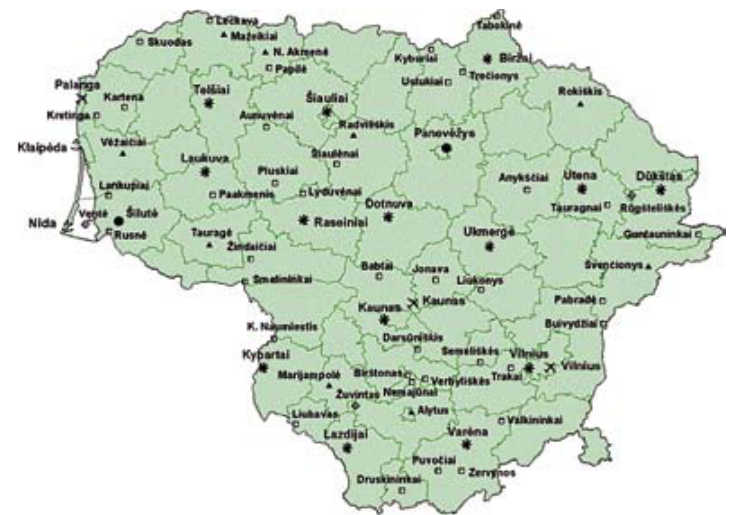
fig. 1. The network of observation stations of the Hydrometeorological Service (Juknevičiūtė, Laurinavičius 2008): – weather station, – aero-weather station,